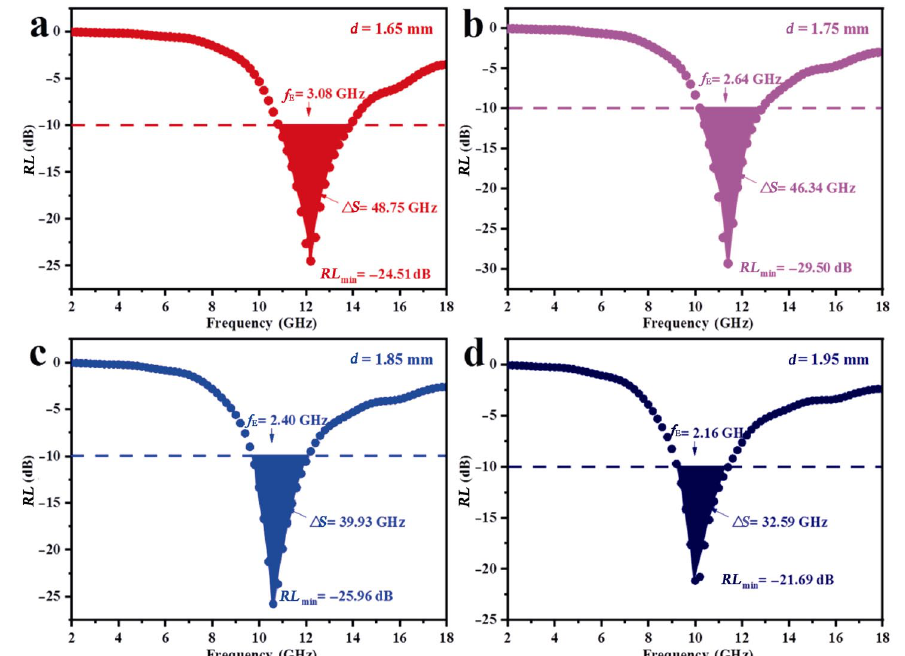
Fig. 8 Reflection loss of porous 3D-SiC/MDCF-II-wax composites with various thicknesses: (a) 1.65, (b) 1.75, (c) 1.85, and (d) 1.95